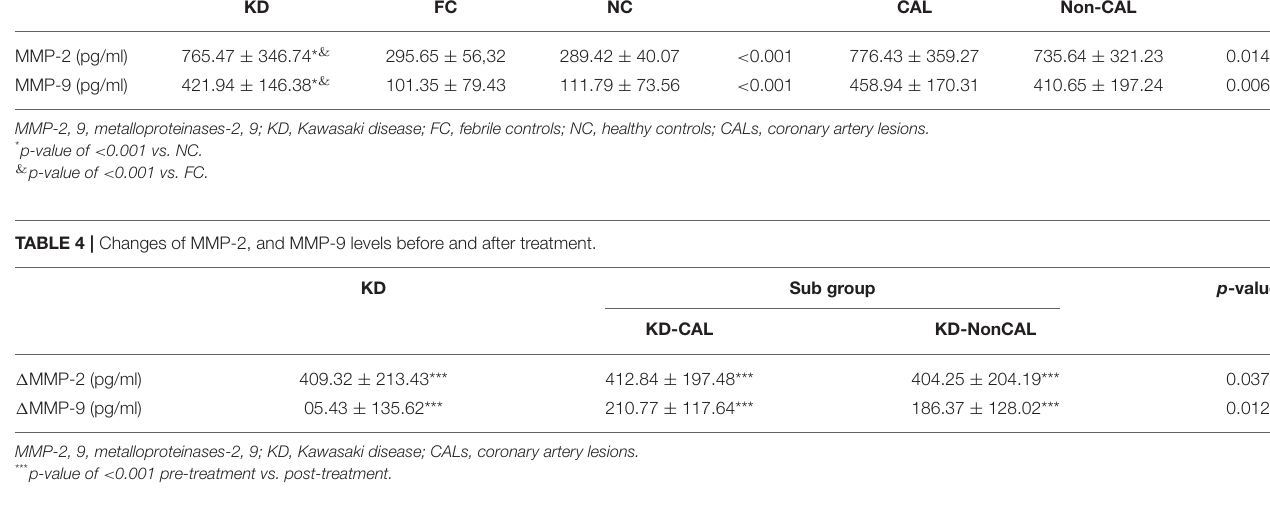
TABLE 3 | Comparison of MMP-2 and MMP-9 levels among different groups. Primary group p -value Sub group p -value KD FC NC CAL Non-CAL MMP-2 (pg/ml)